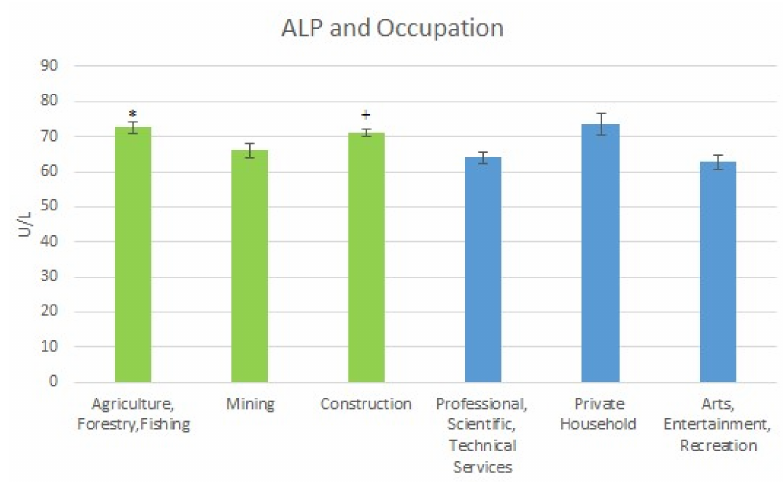
Figure 6. Occupation and Mean ALP Levels. * Significant difference between agriculture and professional and arts. + Significant difference between construction and professional and